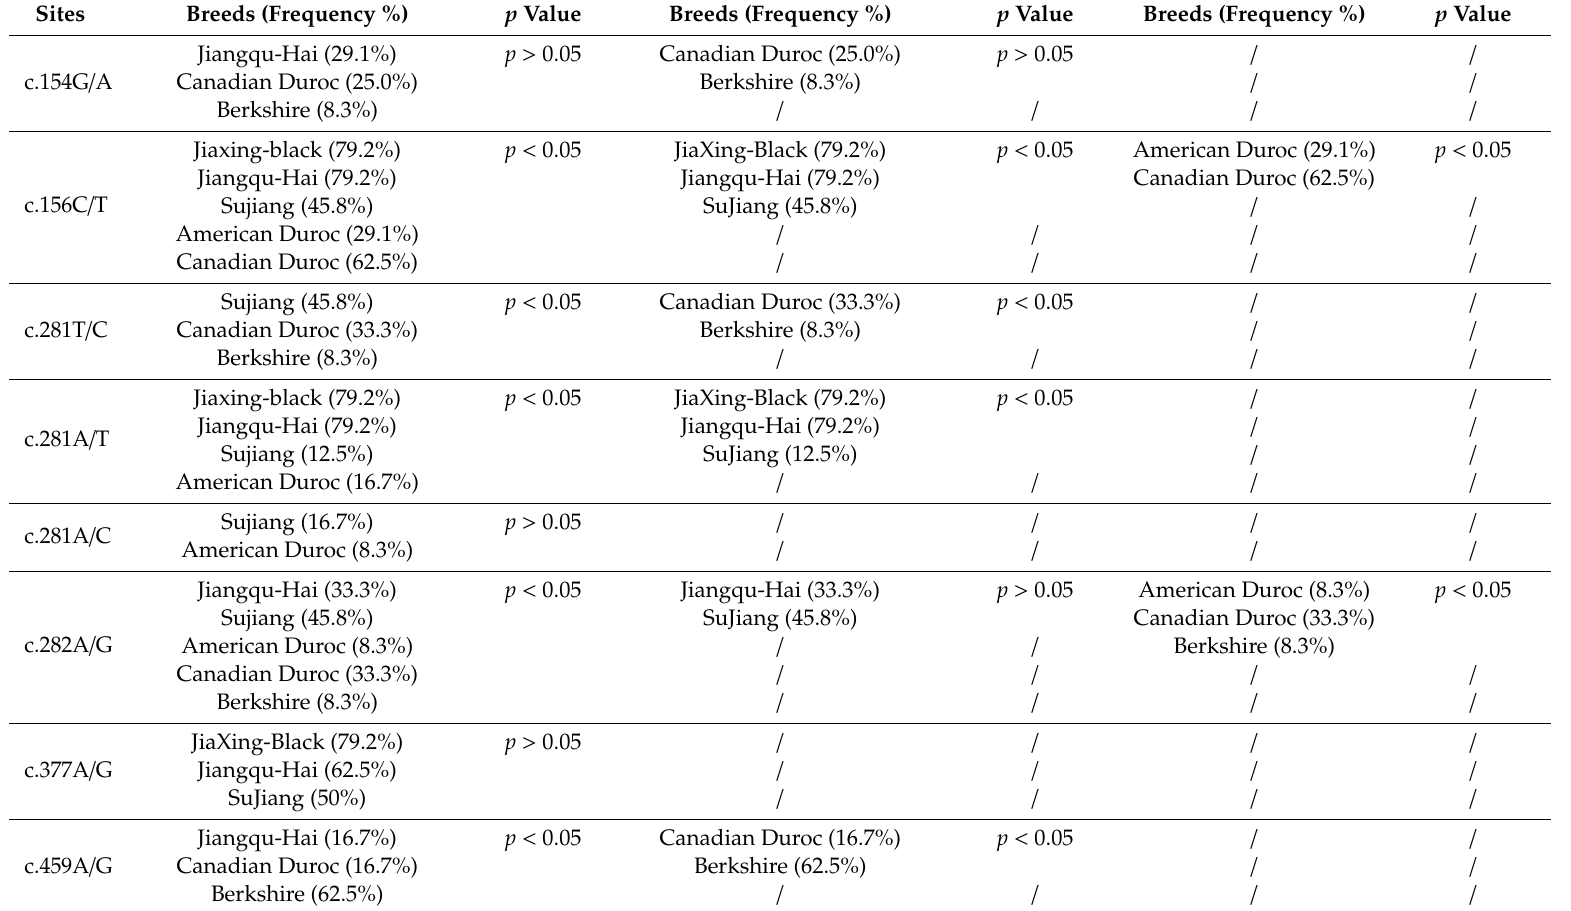
Table 5. A di ff erence of variable frequencies in various